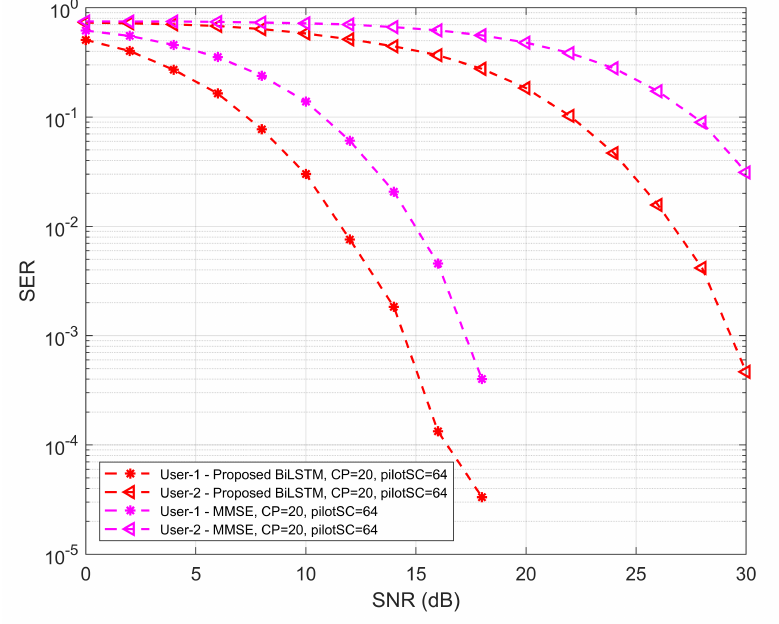
Figure 9. SER versus SNR performance of proposed Bi-LSTM model and MMSE